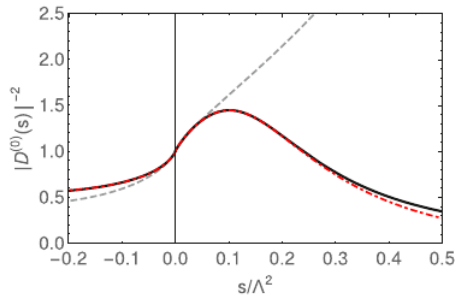
Figure 2. Modulus squared of the Omnès function Ω (0) ( s